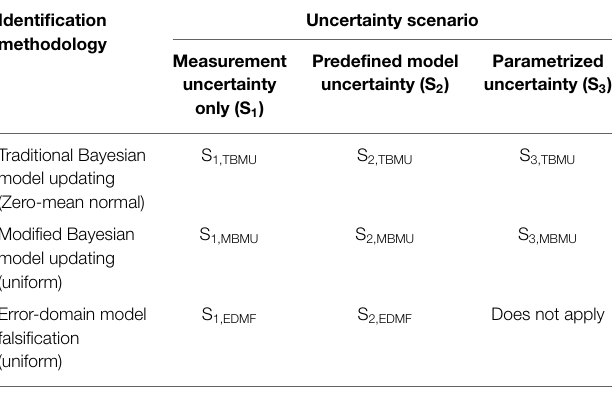
TABLE 2 | Eight identification scenarios are used for comparisons. Four separate model uncertainty distributions are derived for: